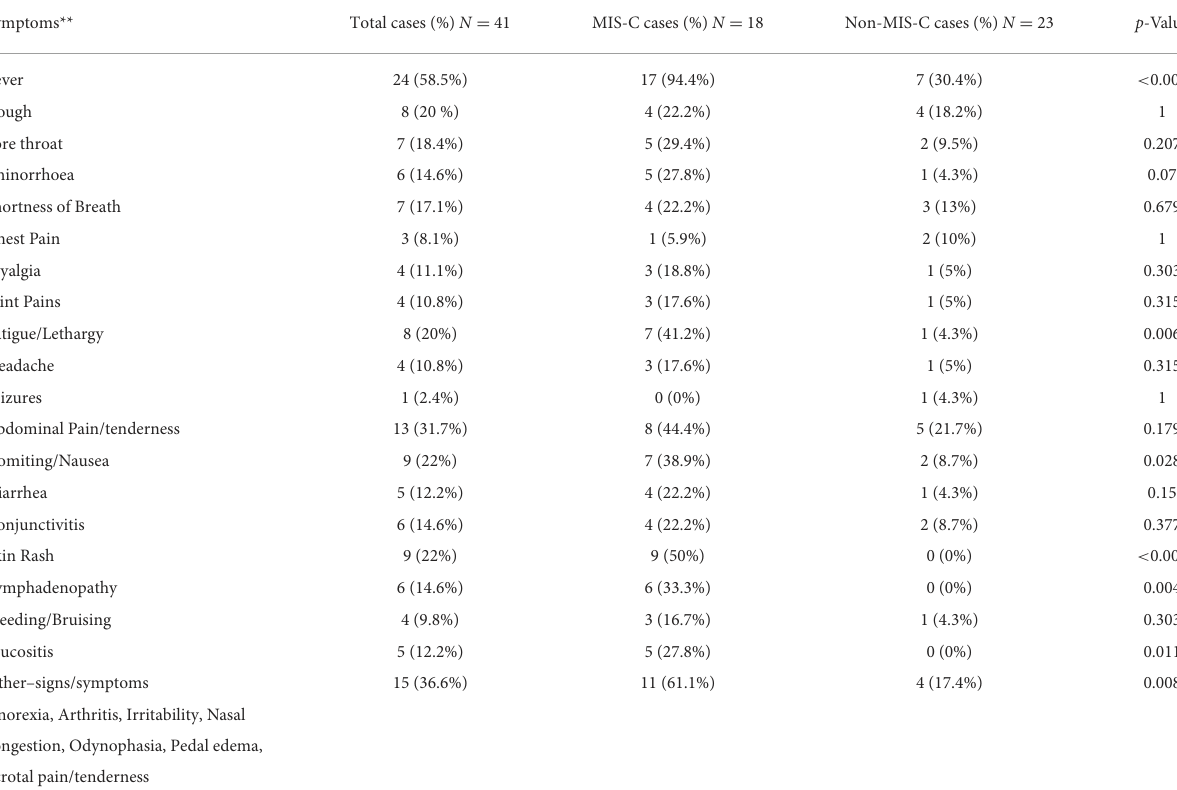
TABLE 2A Clinical symptoms of children hospitalized with COVID-19, MIS-C * vs. non-MIS-C.